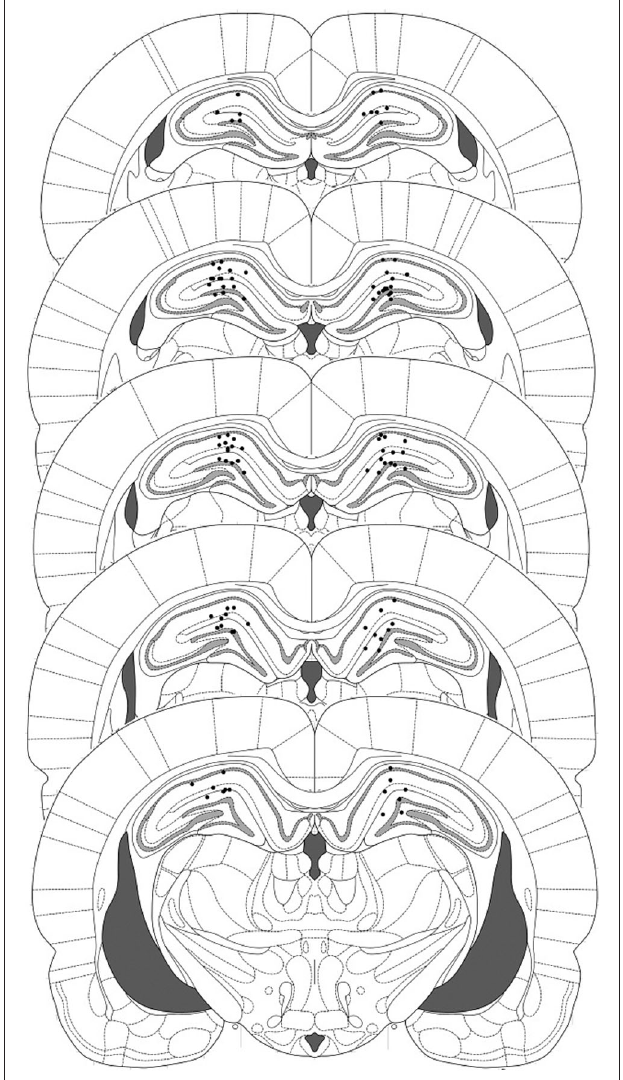
FIGURE 1 | Representation of injector placements in the dorsal hippocampus . Histological evidence of injector tips was observed and correspond to the filled